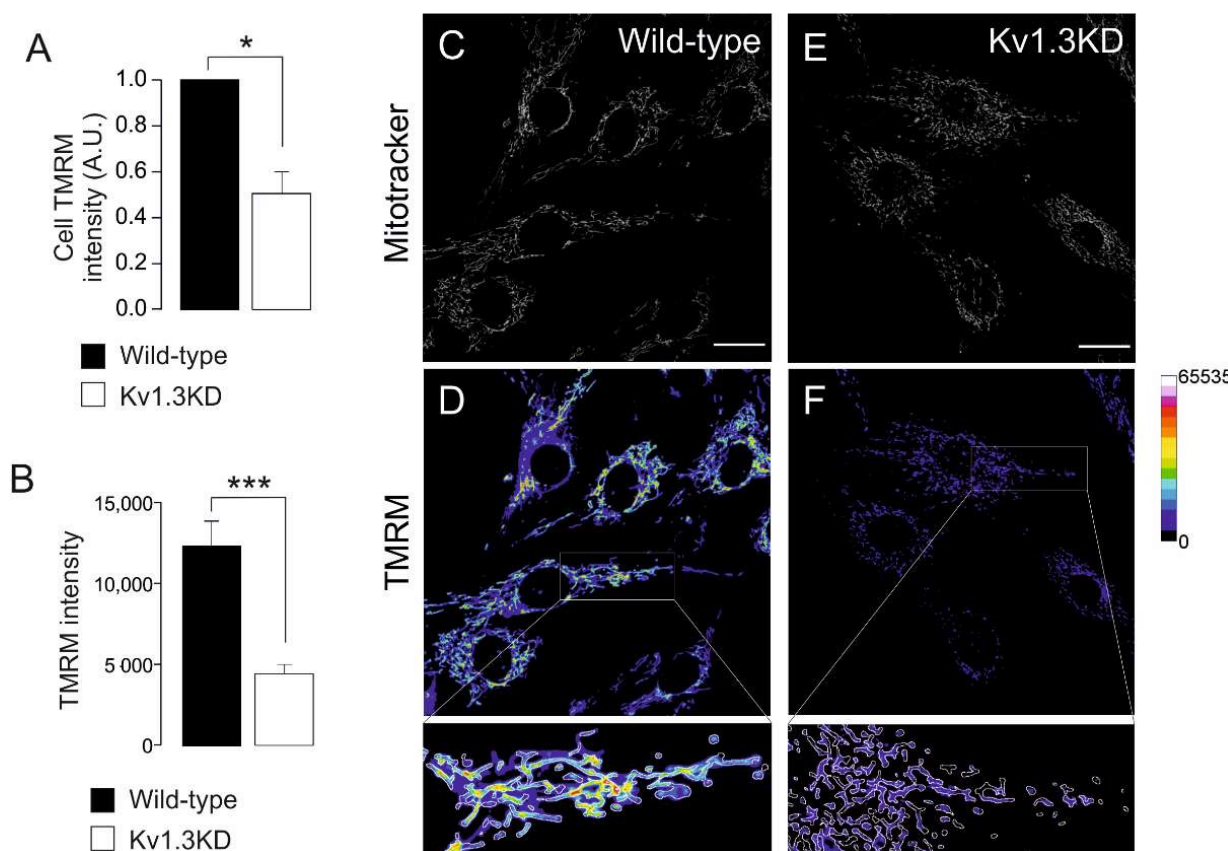
Figure 5. Kv1.3 regulates the mitochondrial membrane potential during the cell cycle. Ablation of Kv1.3 impairs the mitochondrial membrane potential. ( A ) TMRM intensity in wild-type (black bar) and Kv1.3KD (white bar) 3T3-L1 preadipocytes was analyzed with flow cytometry. The data are the mean ± SE ( n = 3), * p < 0.05 (Student’s t -test). ( B ) TMRM intensity, as determined by confocal imaging. The data are the mean ± SE ( n > 30 cells), ***, p < 0.001 (Student’s t -test). ( C – F ) Representative confocal images showing MitoTracker and TMRM intensity in wild-type ( C , D ) and Kv1.3KD ( E , F ) cells. MitoTracker green ( C – E ) was used to create a mask to detect mitochondrial particles, and the mean intensity was analyzed in the TMRM channel ( D – F ). The color scale on the right represents TMRM intensity values. The scale bar represents 20 μm. Bottom panels represent 3x magnification of the insets in D and F. The white insets are magnified images of the regions at the bottom.